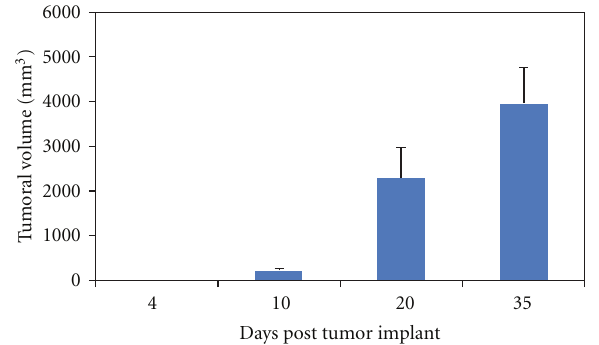
Figure 3: Tumour volume growth for Swarm rat chondrosarcoma (SRC) implanted in paratibial location. Mean values + standard deviation are presented at each time